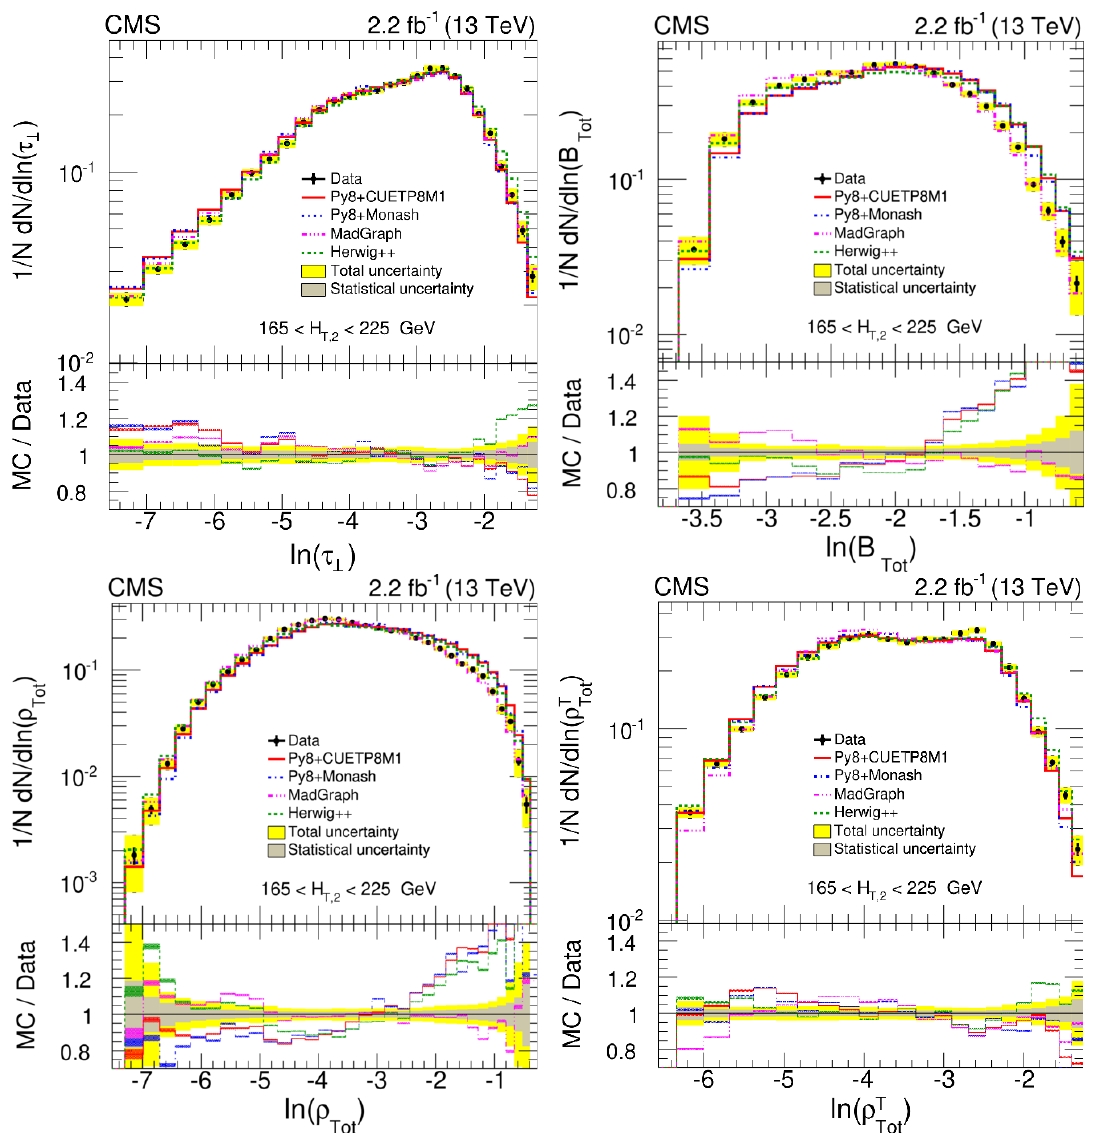
Figure 5 . Normalized di(cid:11)erential distributions of unfolded data compared with theoretical (MC) predictions of pythia 8 CUETP8M1 (red line), pythia 8 Monash (blue dash-dotted line), Mad- Graph 5 a mc@nlo (pink dash-dot-dotted line) and herwig++ (brown dash-dot-dotted line) as a function of ESV: complement of transverse thrust ( (cid:28) ? ) (upper left), total jet broadening ( B Tot ) (upper right), total jet mass ( (cid:26) Tot ) (lower left) and total transverse jet mass ( (cid:26) T 165 < H T ; 2 < 225 GeV. In each ratio plot, the inner gray band represents statistical uncertainty and the yellow band represents the total uncertainty (systematic and statistical components added in quadrature) on data and the MC predictions include only statistical uncertainty.